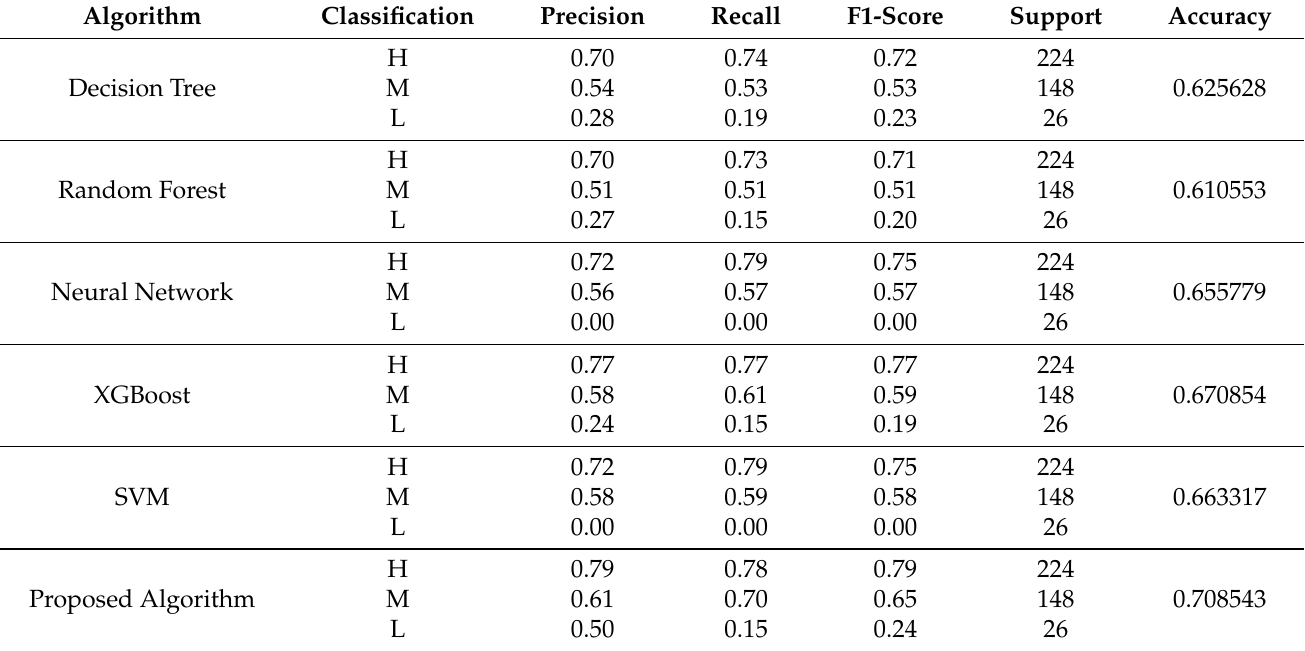
Table 4. Comparing the results with all experimental algorithms on the ‘xAPI-Edu-data’ dataset.